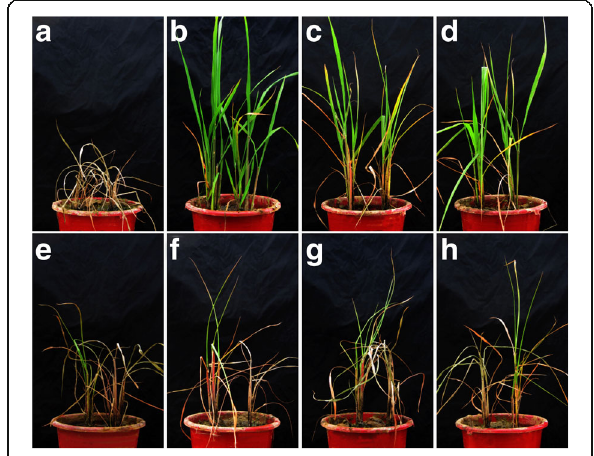
Fig. 5 Photograph of resistance level to BPH of improved Jin 23B at the tillering stage (the 25 days after infested with BPH). Number A to H represent Jin 23B, Jin 23B ( Bph14 / Bph15 ), Jin 23B ( Bph14 ), Jin 23B ( Bph15 ), Jin 23B ( Bph3 ), Jin 23B ( Bph18 ), Jin 23B ( Bph20 ), Jin 23B ( Bph21 ),